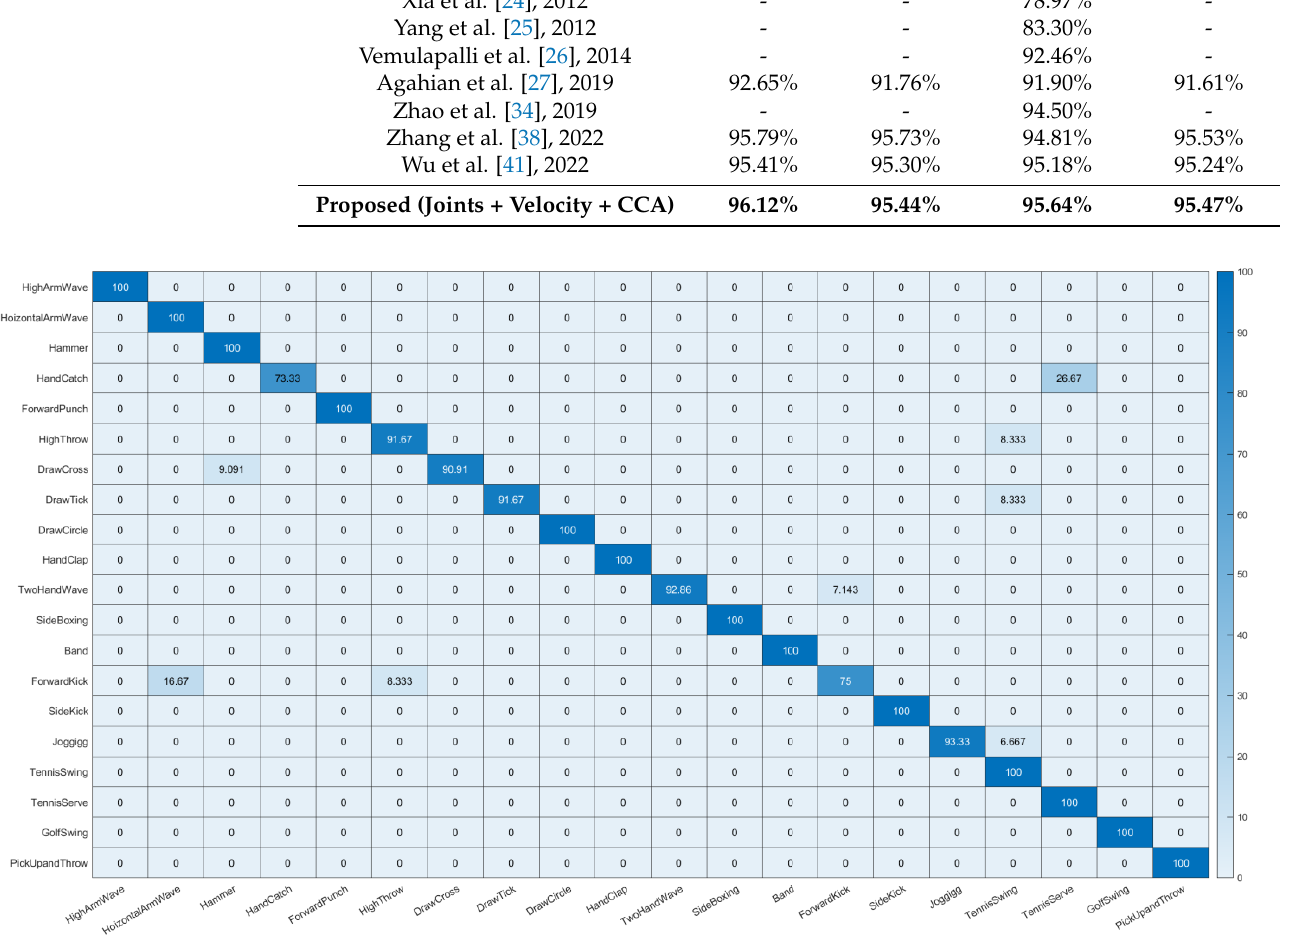
Figure 10. Confusion chart for MSR-Action3D dataset using joints + velocity + CCA.